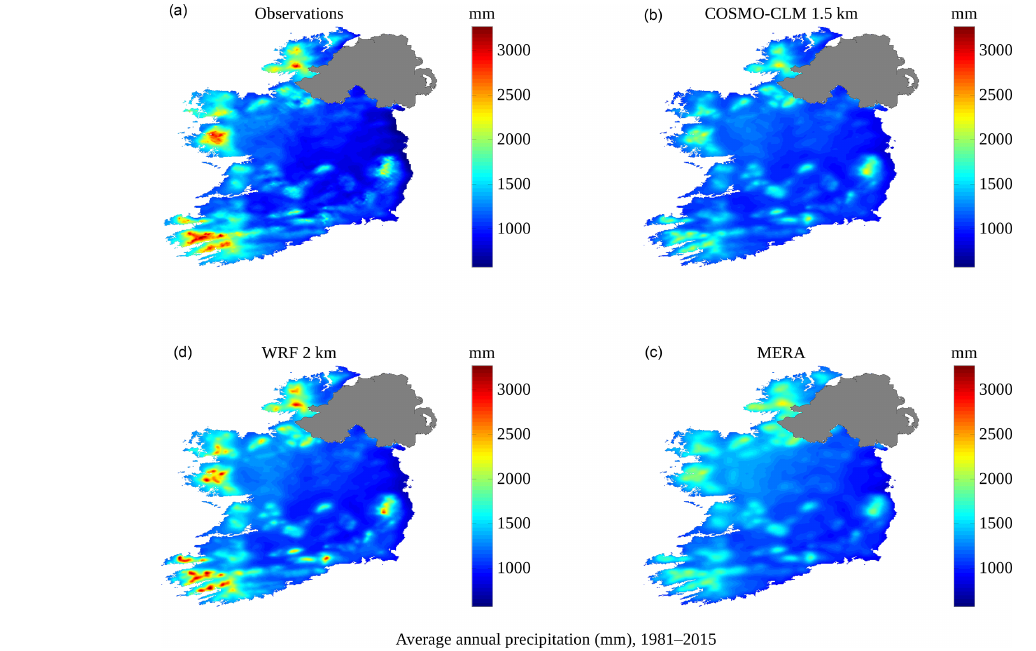
Figure 3. Average annual rainfall (mm) over the period 1981–2015. Shown are the values found from (working clockwise): (a) gridded observations provided by Met Éireann; (b) the COSMO-CLM 1.5km dataset; (c) the MÉRA dataset; (d) the WRF 2km dataset.